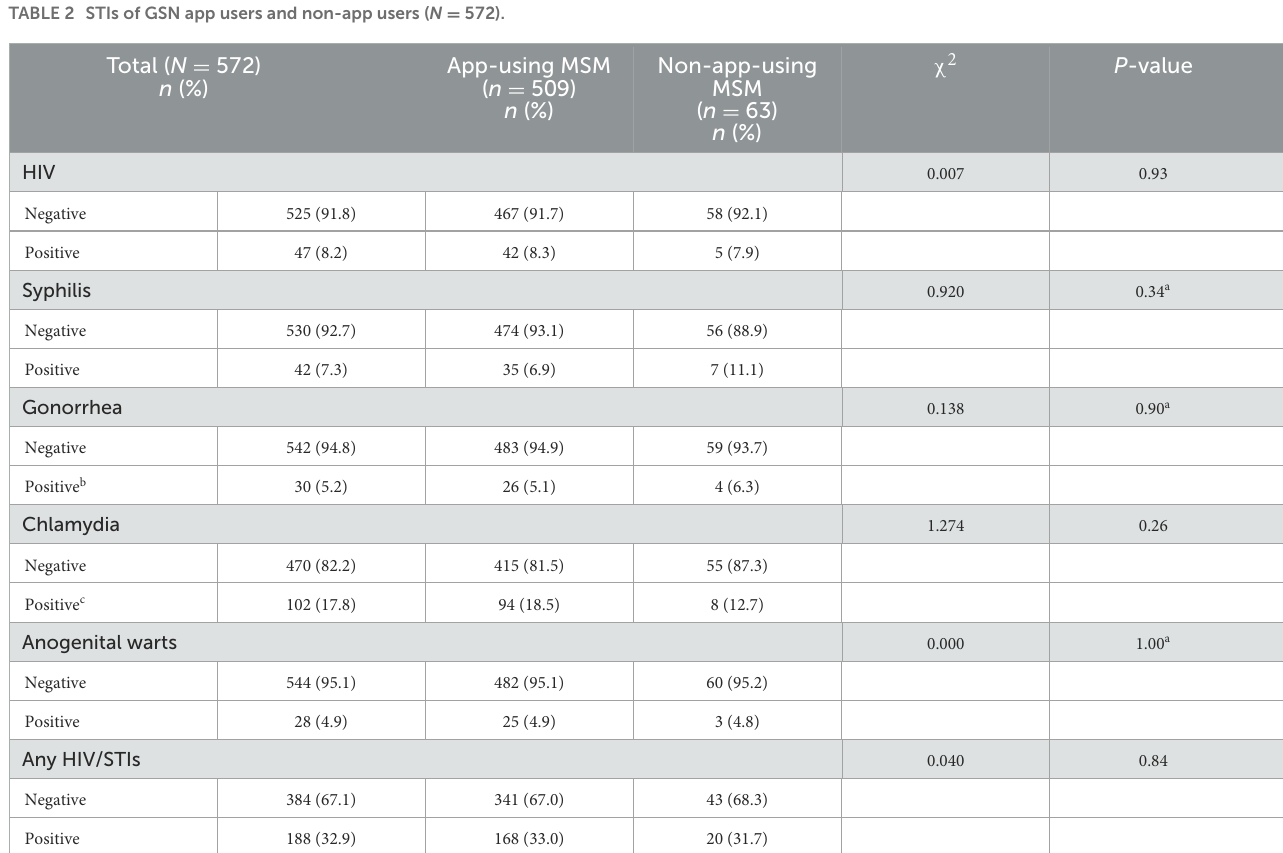
a ContinuitycorrectionChi-squaretest. b